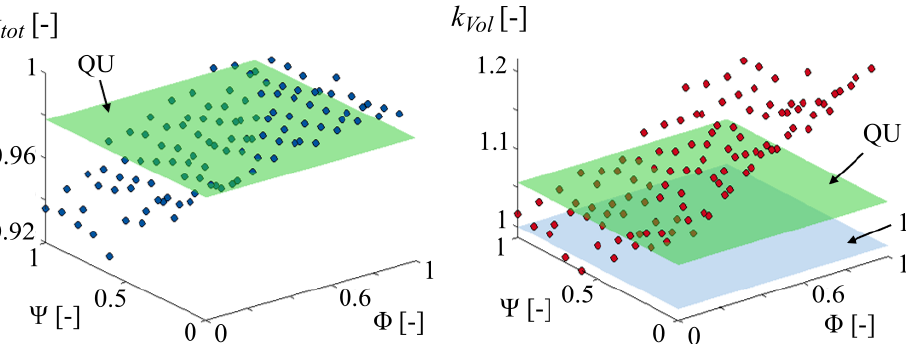
Figure 22. Influence of Φ and Ψ on k tot ( left ) and k Vol ( right